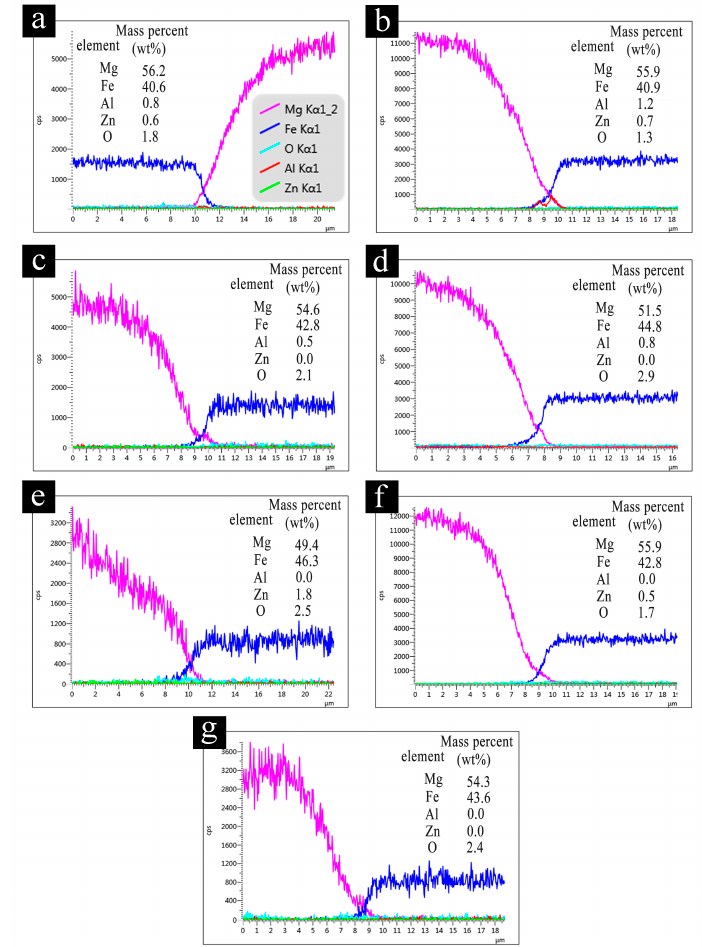
Figure 8. The analysis of a line scan by energy dispersive spectroscopy (EDS) experimentation using two methods in four materials: ( a ) FSKSW AZ31/DP600; ( b ) VDW AZ31/DP600; ( c ) FSKSW AZ31/non-zinc-coated DP600; ( d ) VDW AZ31/non-zinc-coated DP600; ( e ) FSKSW Mg99.50/DP600; ( f ) VDW Mg99.50/DP600; and ( g ) FSKSW Mg99.50/non-zinc-coated DP600.